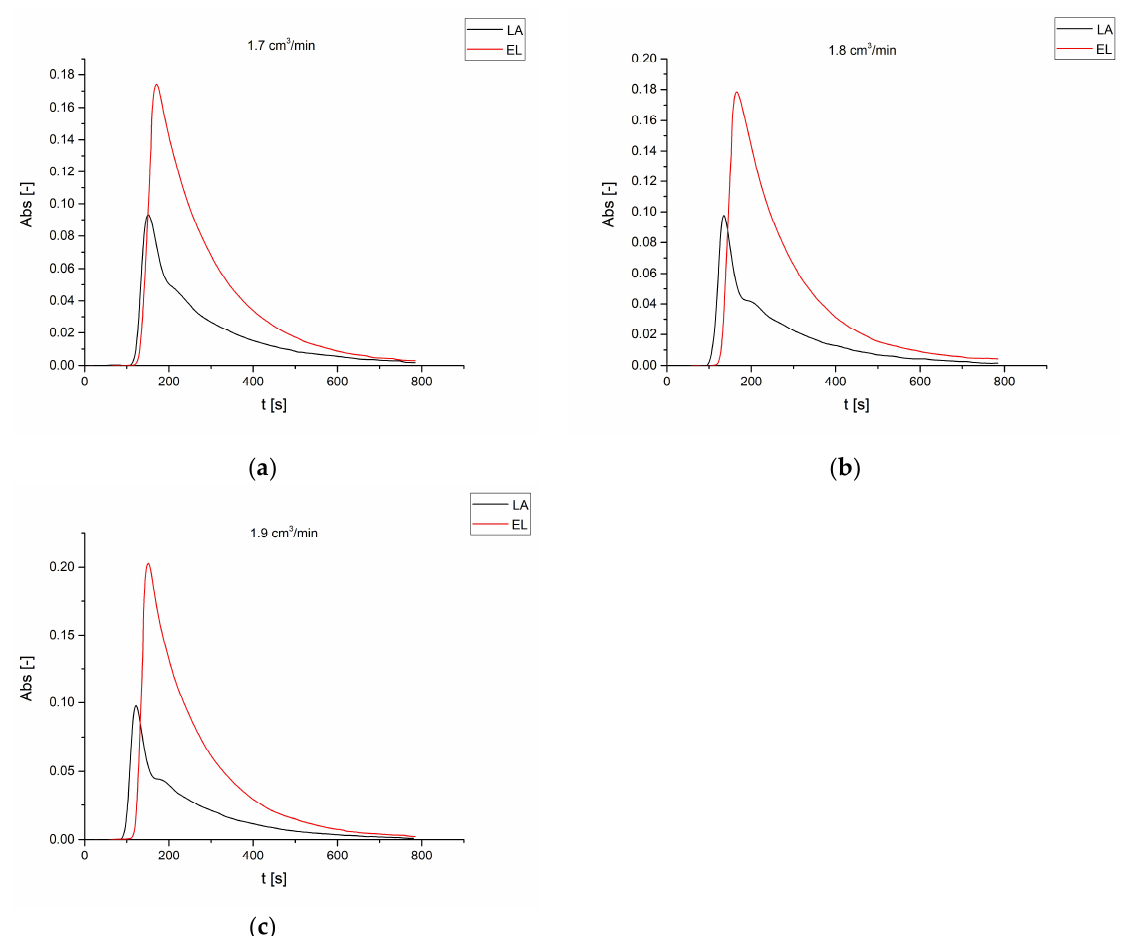
Figure 6. UV spectra of LA and EL 6 M at 313.15 K at different flow rates. ( a ): 1.7 cm 3 /min. ( b ): 1.8 cm 3 /min. ( c ): 1.9 cm 3 /min.